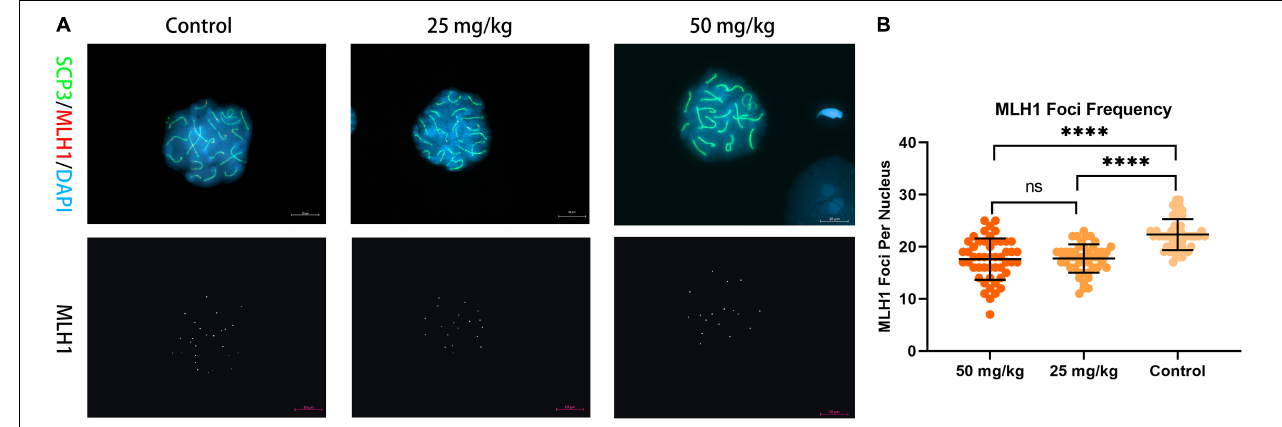
FIGURE 4 | Recombination foci in pachytene spermatocytes in HU-exposed male mice. (A) Pachytene spermatocyte chromosome spreads were immunostained with antibody SCP3 (green) and MLH1 (red) in mice injected with 25 and 50 mg/kg of HU and controls. Mice injected with 25 and 50 mg/kg of HU show a reduction in recombination foci. MLH1 foci are shown in white on the lower panel of (A) . Scale bars = 10 µ m. (B) Quantification of the MLH1 foci per pachytene nuclei; MLH1 foci frequency from control and mice injected with 25 and 50 mg/kg of HU. Five mice were analyzed for each group, and the data as mean ± SD were compared between groups using the Mann–Whitney U -test. Asterisks denote significance ( n = 100; ∗∗∗∗ p <